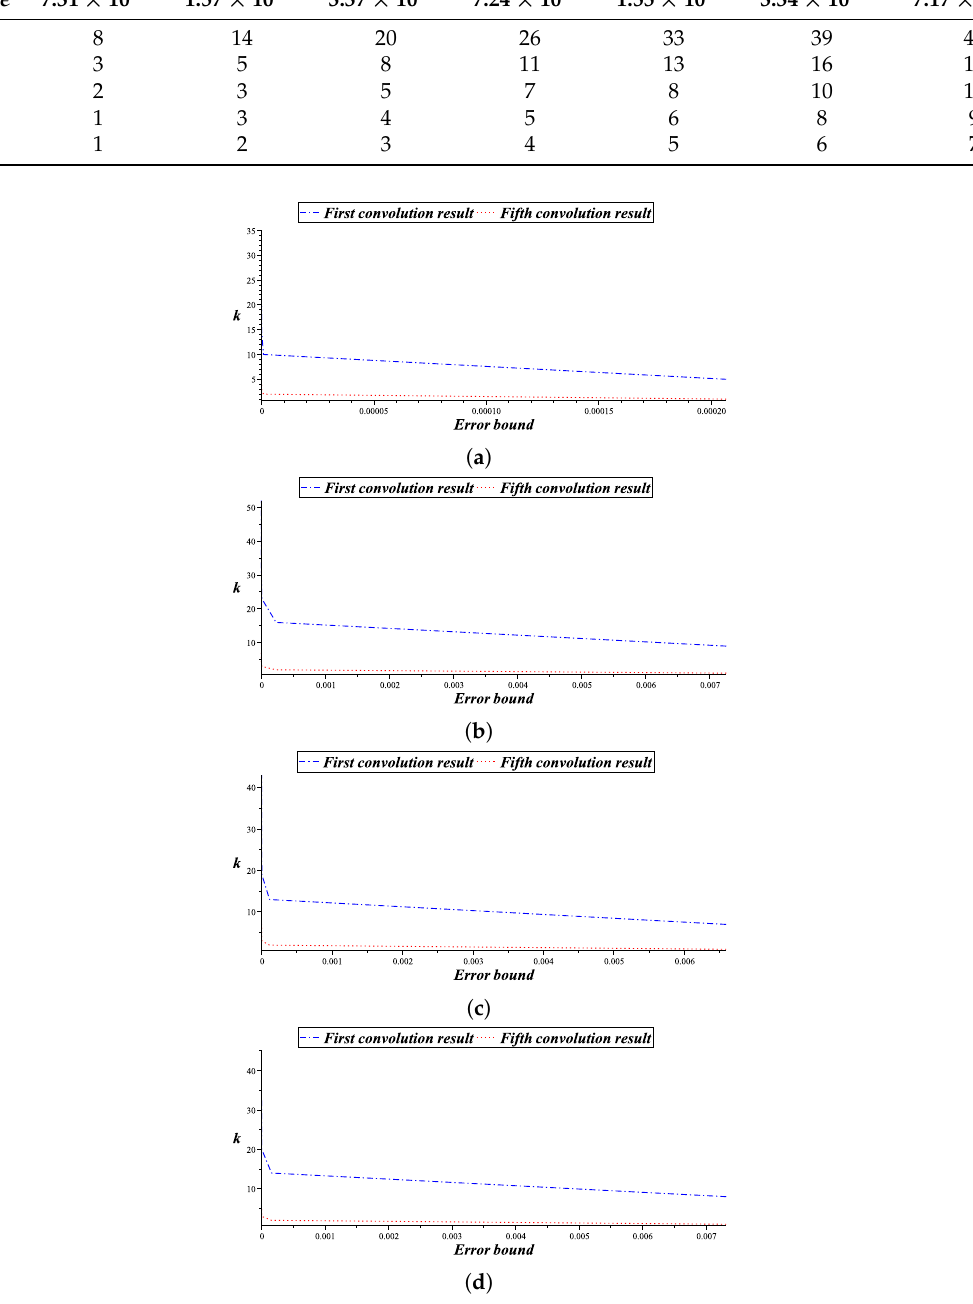
Figure 2. Comparison between first and fifth convolutions. This shows error decreases with the increase of convolution. Of course, it decreases with the increase of subdivision depth. ( a ) 2-point tensor product scheme [12]; ( b ) 3-point tensor product scheme [30]; ( c ) 4-point tensor product scheme [8]; ( d ) 4-point tensor product scheme